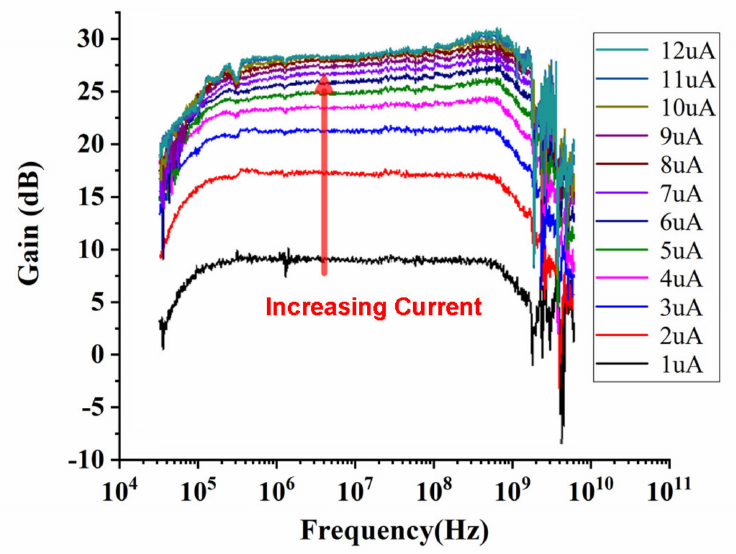
Figure 14. Measured gain with different biasing current I b1 ranging from 1 to 12 µ A at 4.2